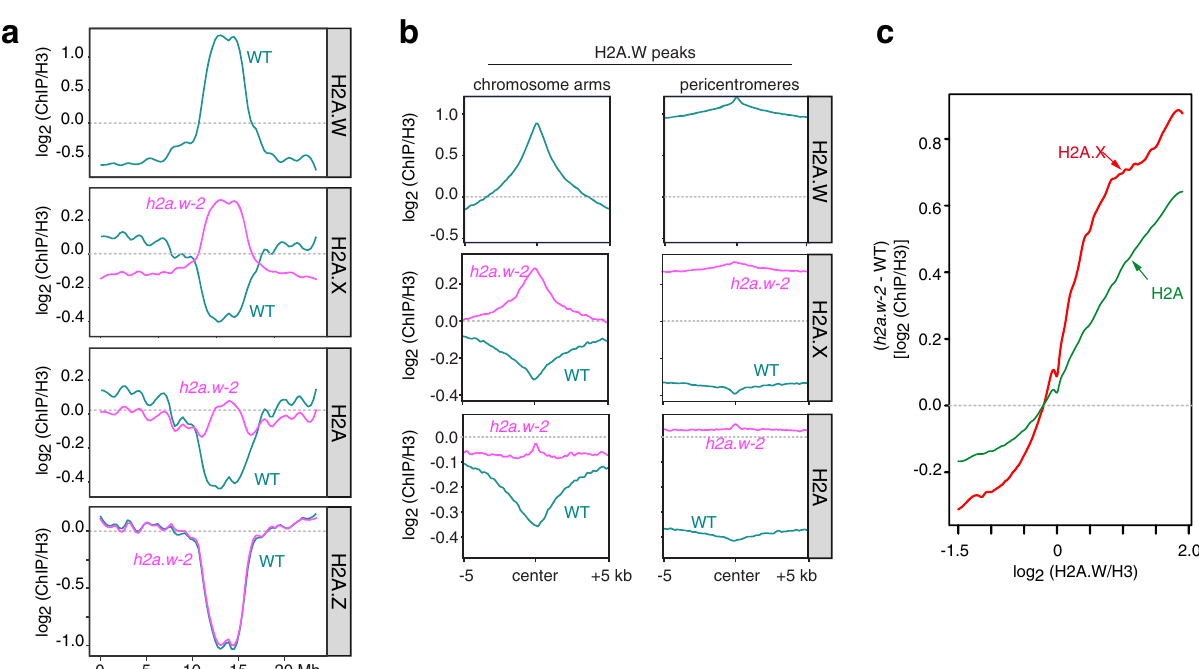
Fig. 4 Replicative H2A and H2A.X replace H2A.W in h2a.w-2 . a Locally weighted scatterplot smoothing (LOESS) fi t of H2A.W, H2A.X, replicative H2A and H2A.Z levels averaged in 1 kb bins across chromosome 3 in WT and h2a.w-2 . Average of two replicates shown. b Metaplots of average H2A.W, H2A.X, and replicative H2A levels from two replicates over H2A.W peaks in the chromosome arms and pericentromeres. c Smoothing spline fi ts (50 degrees of freedom) of changes in H2A.X and replicative H2A levels ( h2a.w-2 minus WT; log 2 ChIP/H3) in 1 kb windows plotted against WT H2A.W level. Source data underlying Fig. 4a are provided as a Source Data fi le.